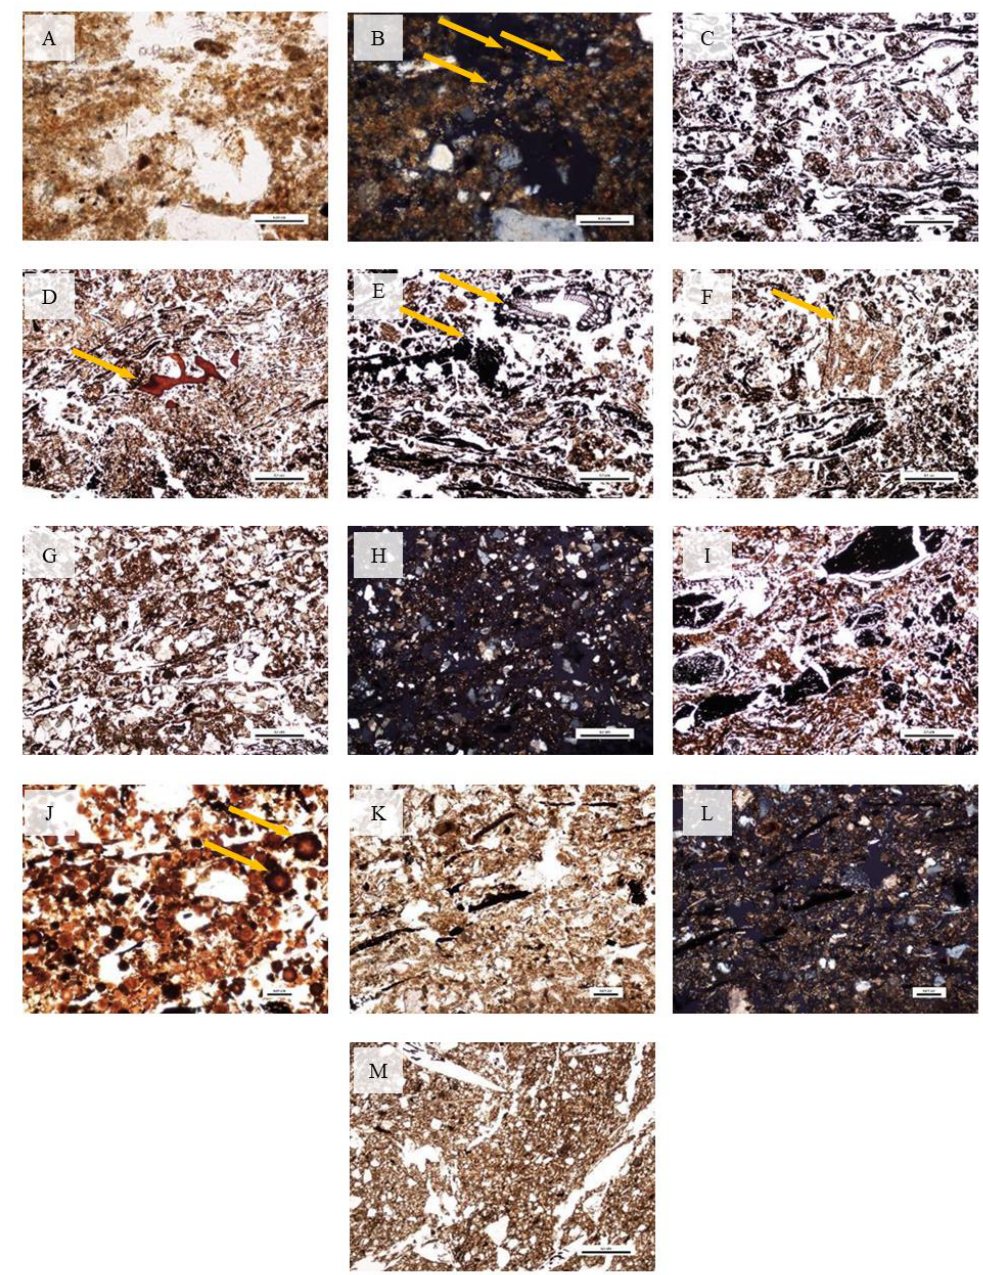
Figure 6. ( A , B ) Faecal spherulites and phytoliths associated with dung (indicated by arrows) (scale: 0.01 cm; PPL, XPL). ( C ) Laminated, charred plant matter (scale: 0.1 cm; PPL). ( D ) Burnt bone fragment (indicated by arrow) (scale: 0.1 cm; PPL). ( E ) Laminated, charred plant matter (indicated by arrows) (scale: 0.1 cm; PPL). ( F ) Burnt daub fragment in the charred matrix (indicated by arrow) (scale: 0.1 cm; PPL). ( G , H ) Material of the 1st platform of the hearth (scale: 0.1 cm; PPL, XPL). ( I ) Charred wood and fine plant matter (scale: 0.1 cm; PPL). ( J ) Detail of I with leucophosphate (indicated by arrows) (scale: 0.01 cm; PPL). ( K , L ) Fine, calcareous ash layer (scale: 0.01 cm; PPL, XPL). ( M ) Material of the 2nd platform of the hearth with vegetal tempering (void) (scale: 0.1 cm; PPL).